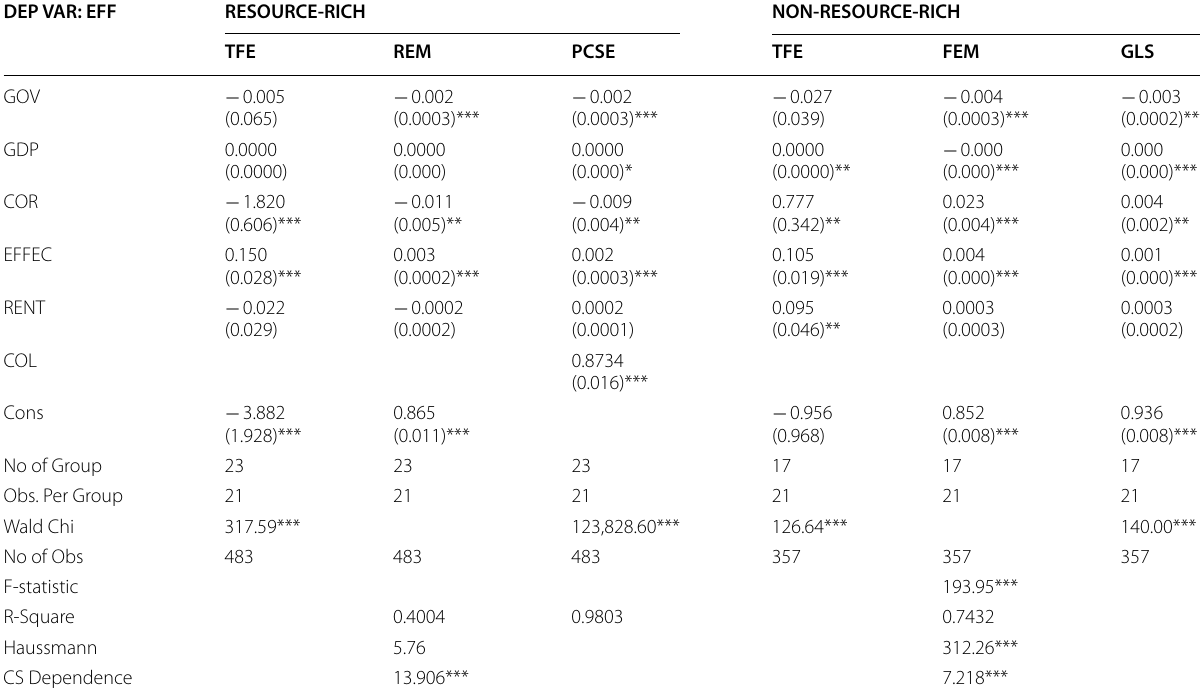
Table 9 Drivers of government spending efficiency in resource-rich and non-resource-rich region DEP VAR: